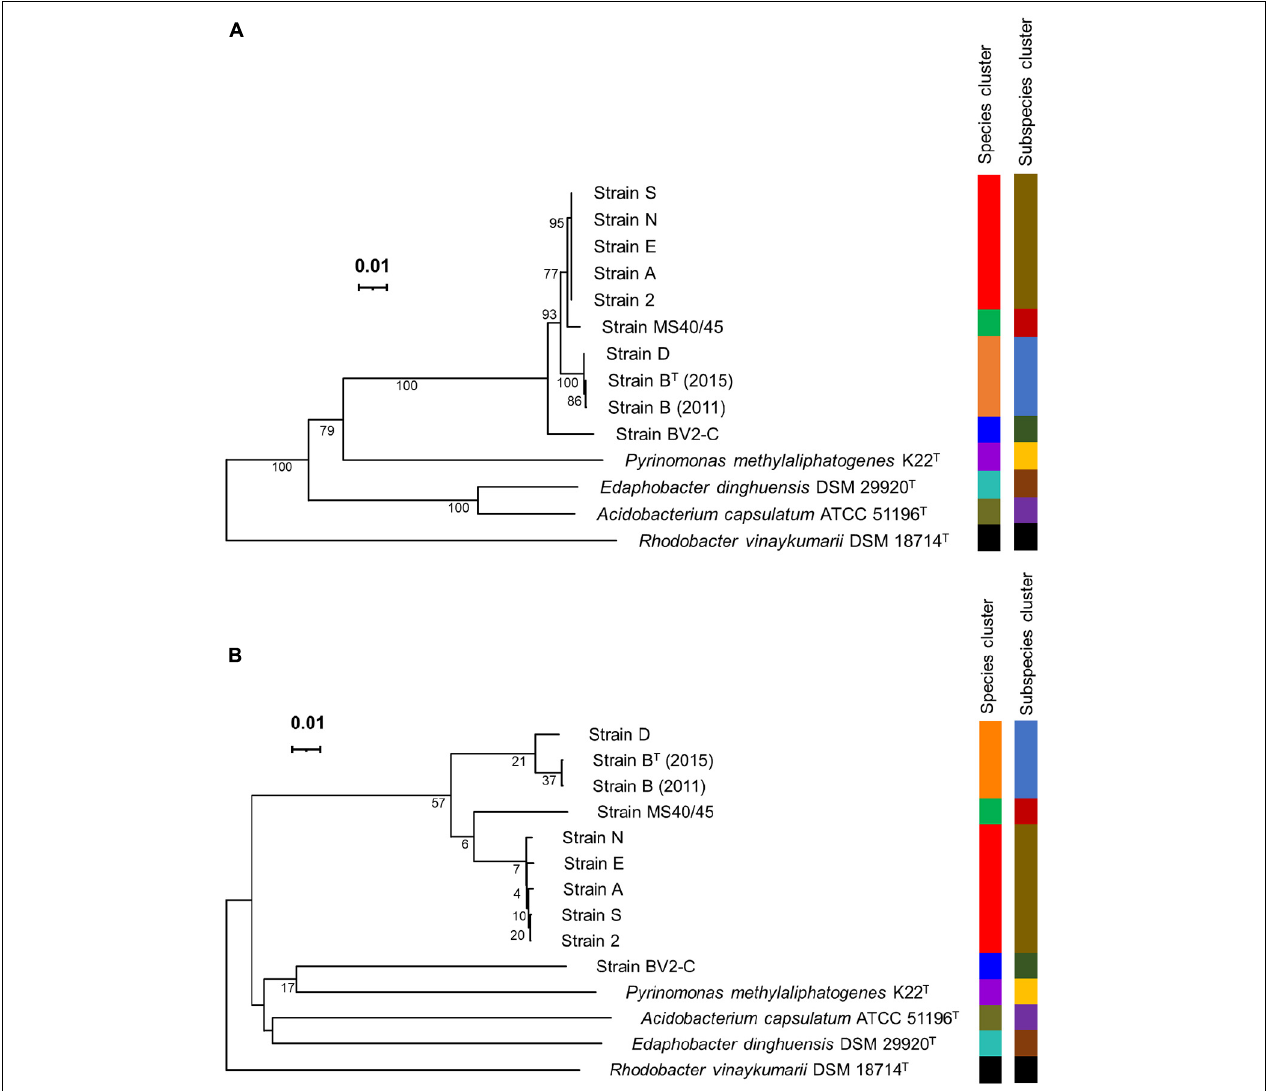
FIGURE 4 | Phylogenetic trees based on 16S rRNA sequences and whole-genome sequences. (A) Phylogenetic tree showing the position of Chloracidobacterium spp. strains based upon the 16S rRNA gene. (B) Phylogenetic tree based upon Genome BLAST Distance Phylogeny (GBDP) distances for complete genomes. The trees were constructed using FastME v.2.1.6.1 software, which calculates 16S rRNA and GBDP distances; the branch lengths are scaled in terms of GBDP distance formula d 5 . The numbers above the branches are GBDP pseudo-bootstrap support values, with average branch support of 85.5 and 21.7% for the 16S rRNA gene and complete genome trees, respectively. The trees are rooted at the midpoint. Leaf labels are color-coded by affiliation to species and subspecies clusters. The results were obtained using the Type Strain Genome Server (TYGS), a free bioinformatics platform available at